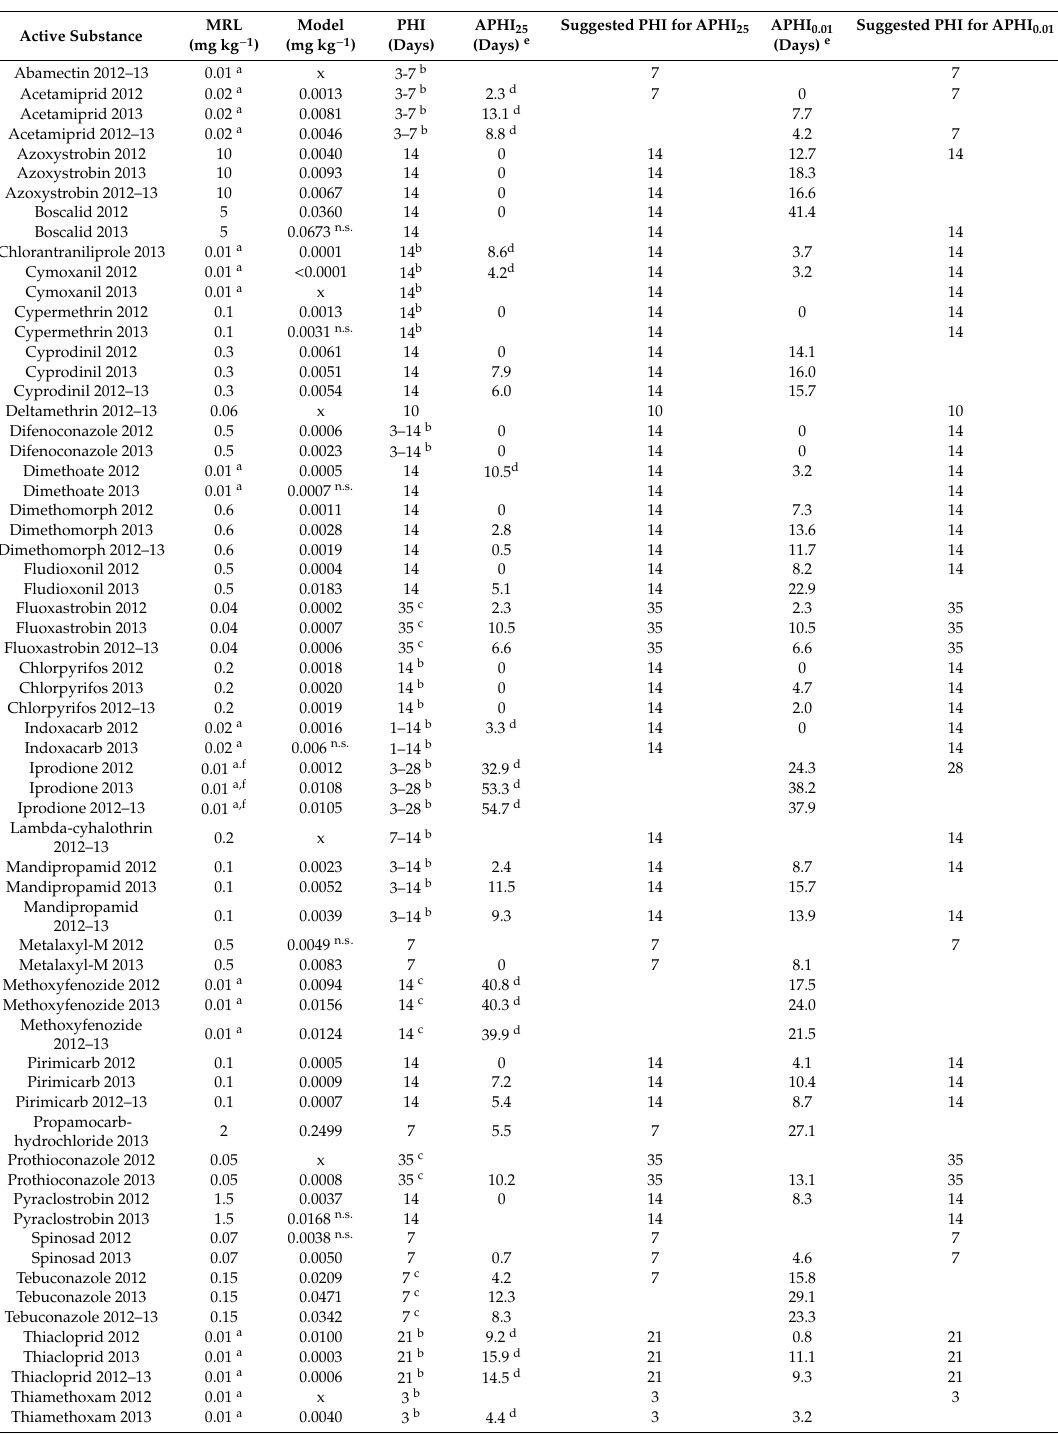
Table 3. Pesticide residues in